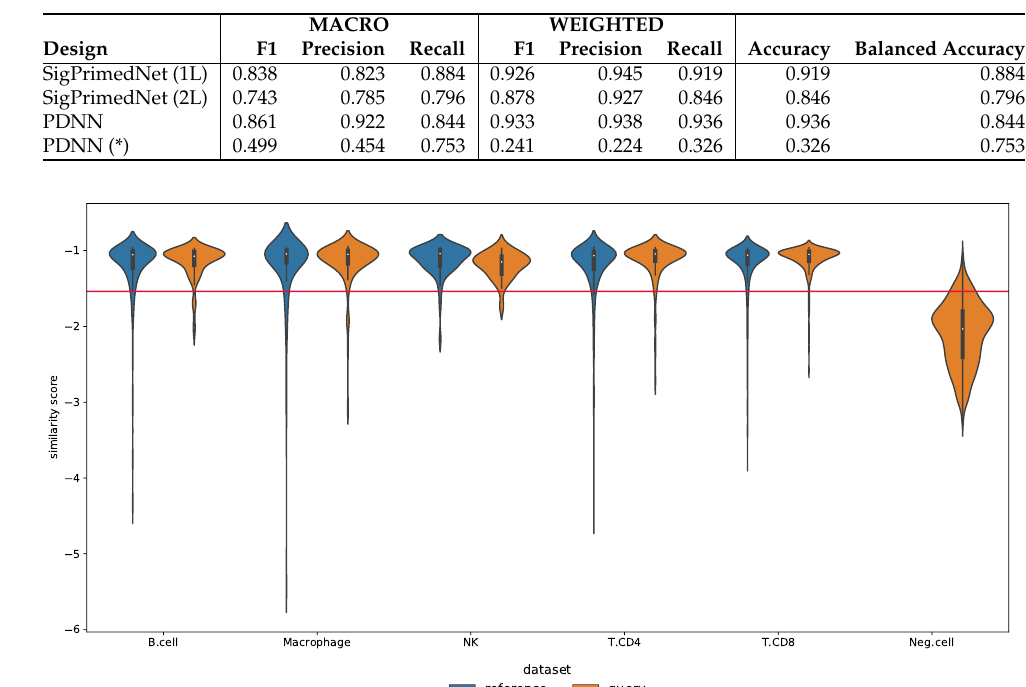
Table 4. Comparison between SigPrimedNet (one-layer (1L) and two-layer (2L) designs) and the best PDNN design on the Melanoma test split.